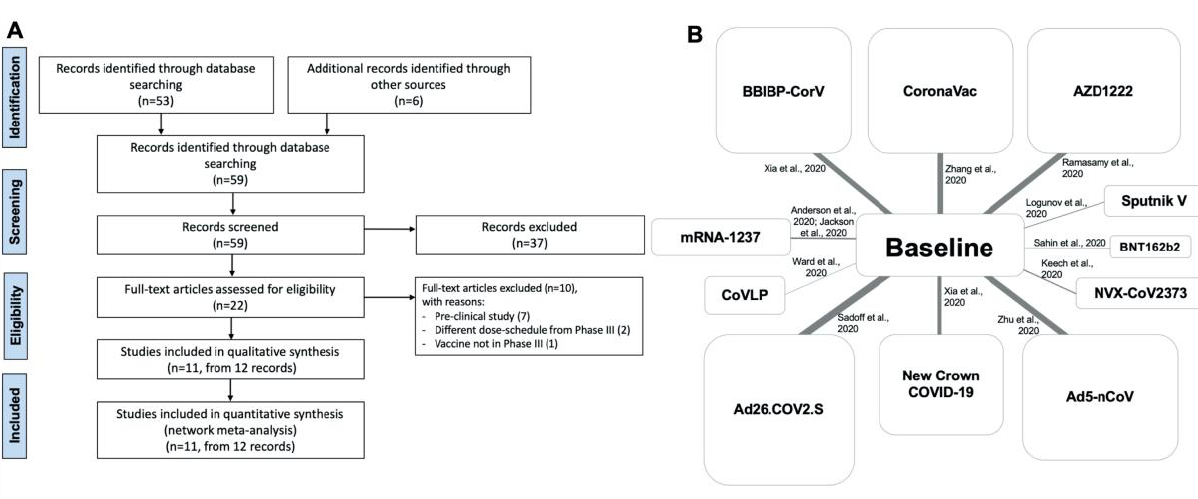
Figure 1. PRISMA-P flow diagram ( A ) and network nodes displaying the geometry of the network across candidate SARS- CoV-2 vaccines ( B ). The links between the nodes indicate the direct comparison across SARS-CoV-2 vaccines vs. baseline. The thickness of the lines is proportional to the number of vaccine recipients, and the area of the boxes is proportional to the number of subjects receiving the same SARS-CoV-2 vaccine. PRISMA-P: Preferred Reporting Items for Systematic Review and Meta-Analysis Protocols; SARS-CoV-2: severe acute respiratory syndrome coronavirus